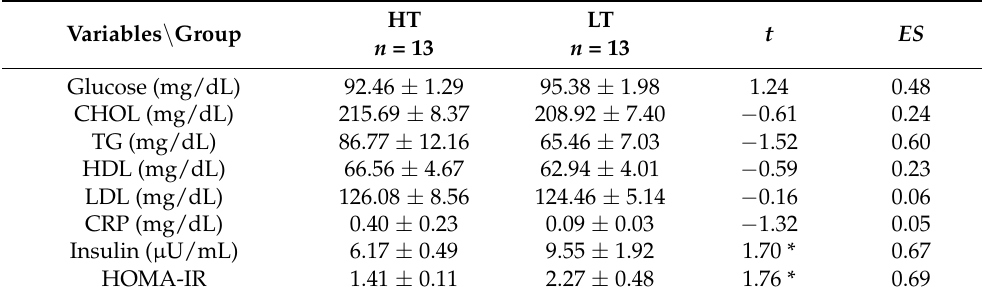
* indicating a statistically significant difference between the two groups ( p < 0.05).